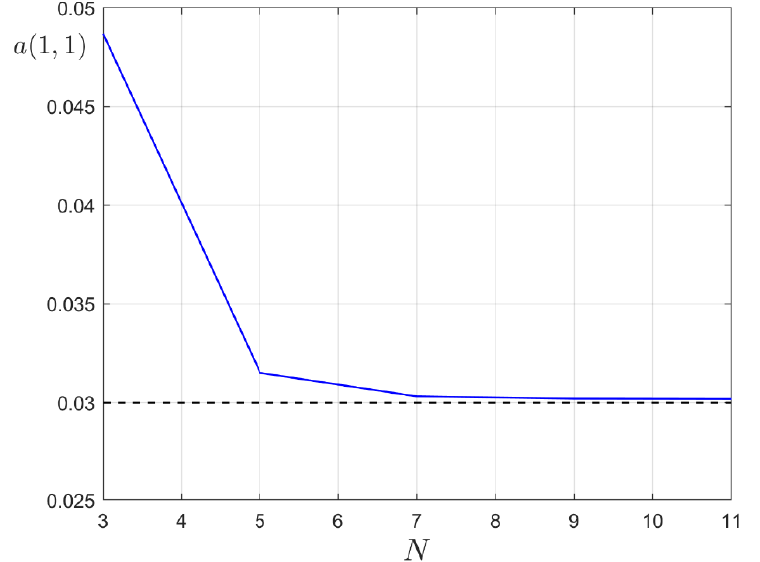
Figure 6. The dependence of the coefficient 𝐵(1,1) on the number of atoms in the chain. Calculations show the invariability of the value 𝐵 (1,1) with an increase in the number of atoms more than seven ( 𝑁 > 7 ). The same result is observed for other values 𝑧′ and 𝜎′ . A plot for the potential 𝑈(𝑥′, 𝑧′) versus 𝑥′ at 𝑧′ = 1 , 𝜎′ = 1, and 𝜀 = 1 for different numbers of atoms in the chain 𝑁 is shown in Figure 7.